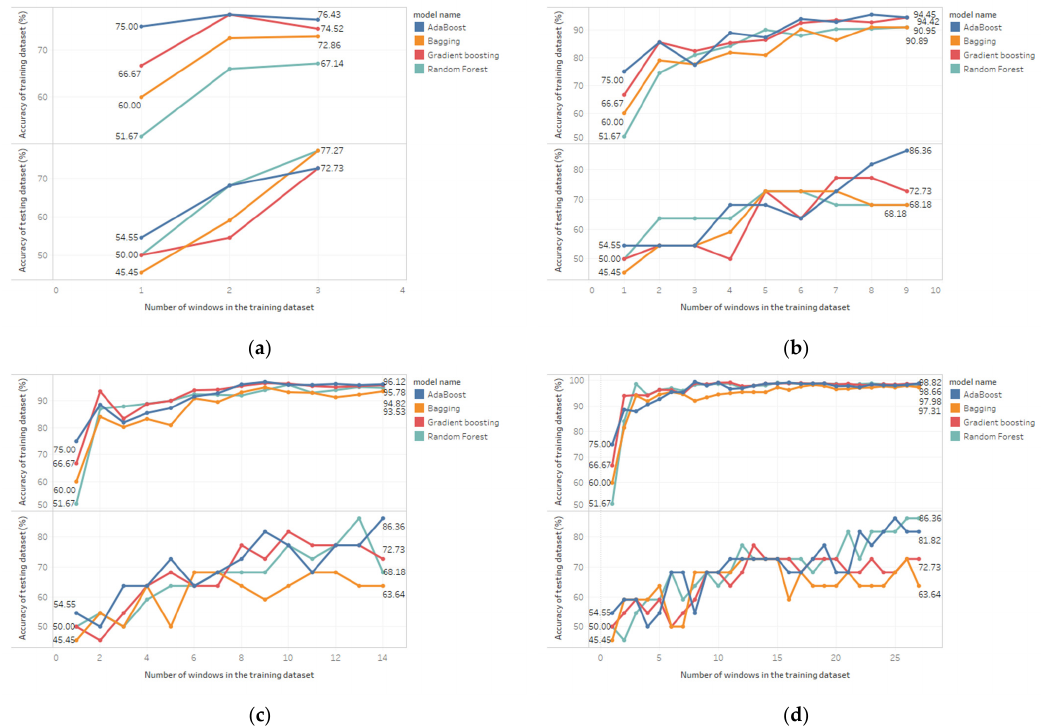
Figure 7. The accuracy of the 4 classification models on training and testing datasets with 54 features using resampling scenario ( a ) RO; ( b ) ROW210; ( c ) ROW240; ( d ) ROW270. Last, it can be observed that a resampling method with a longer overlapping window significantly affects the accuracy of the trained model because the resampling method can improve diversity. This is confirmed by the studies [62,63], which show that an optimal ensemble learning method depends on the diversity of each learner. Diversity can be en- hanced by dividing the original dataset into smaller subsets of data. This can be performed with the resampling method applied in the proposed driving fatigue detection frame- work.